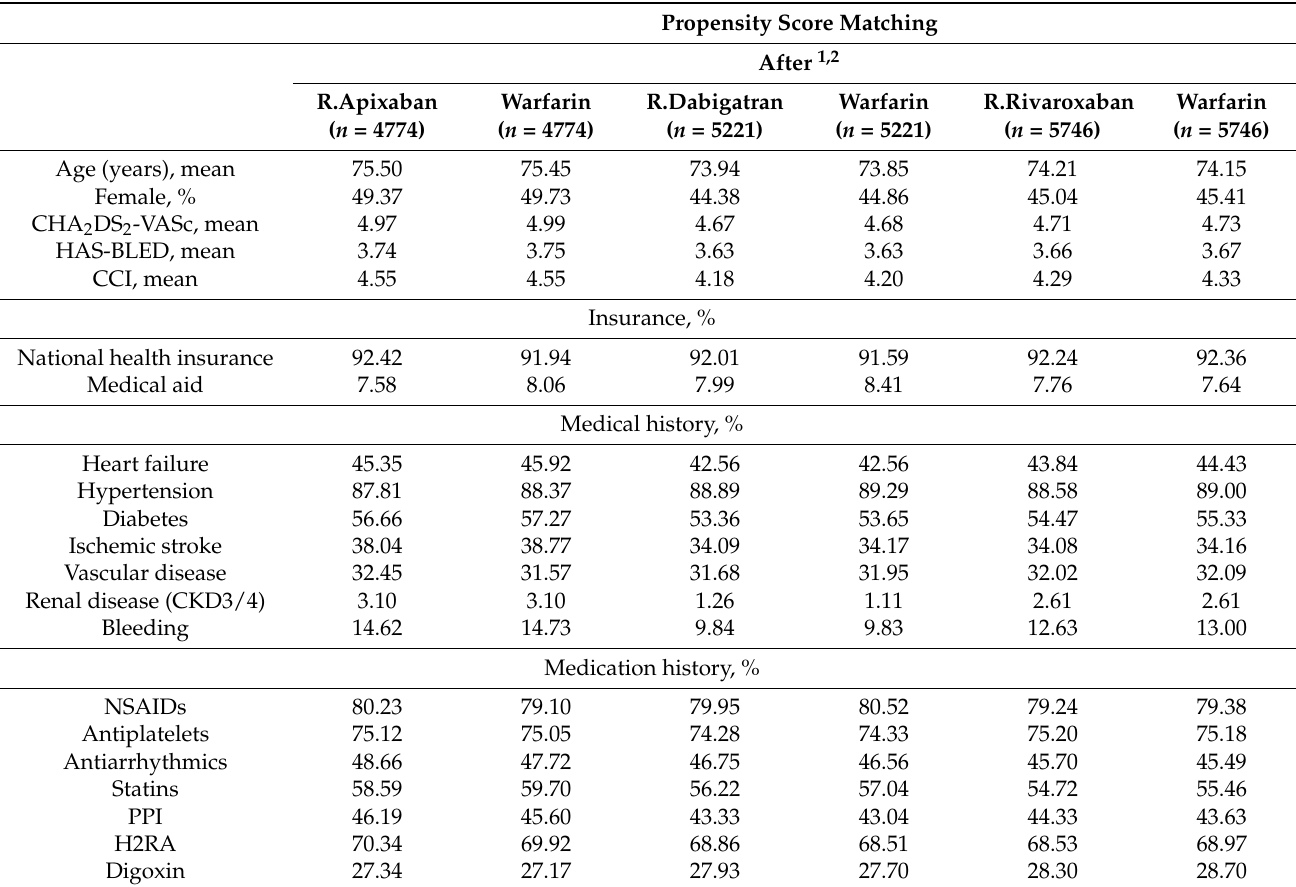
Table 2. Baseline characteristics of patients receiving reduced-dose nonvitamin K antagonist oral anticoagulants and warfarin after propensity score